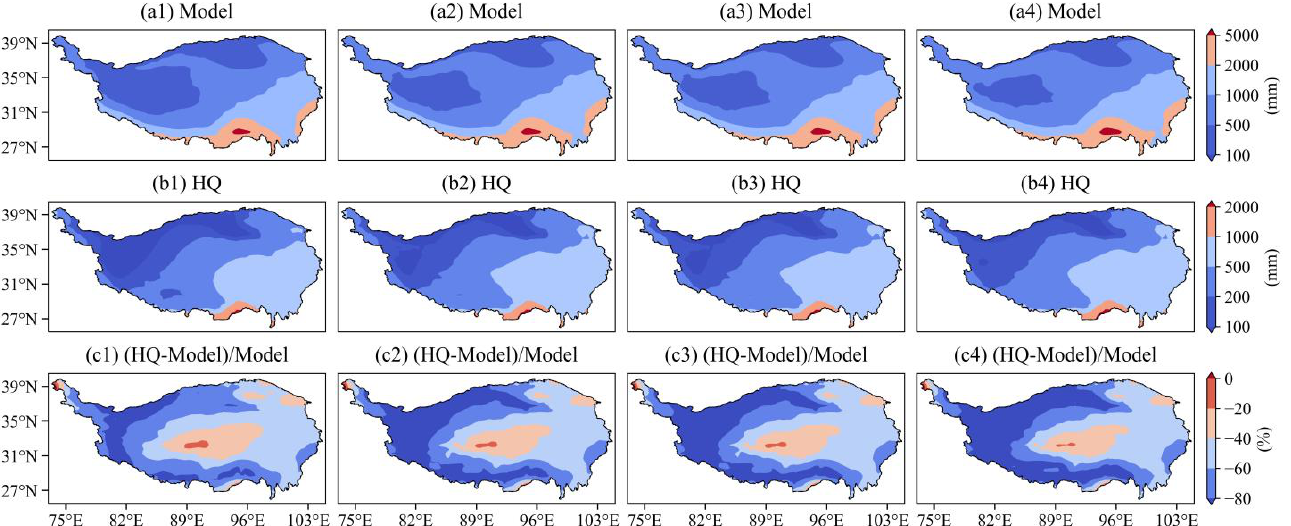
Figure 6. Spatial distribution and variation of annual mean total precipitation before and after HQ correction. ( a – c ) are, respectively, the original, the HQ-corrected, and the variation between them. a1 – a4 are historical, SSP1-2.6, SSP2-4.5, and SSP5-8.5 scenarios, respectively.